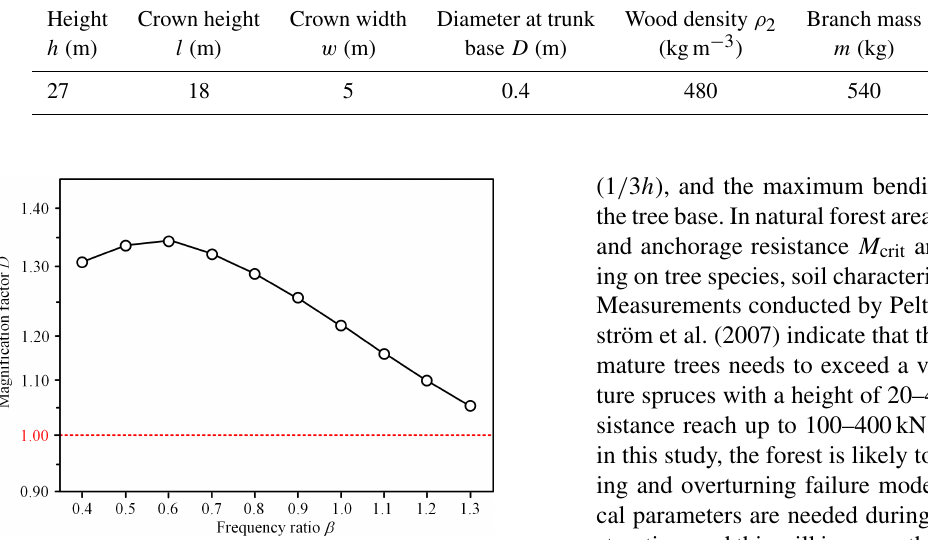
Figure 5. Magnification factor with various frequency